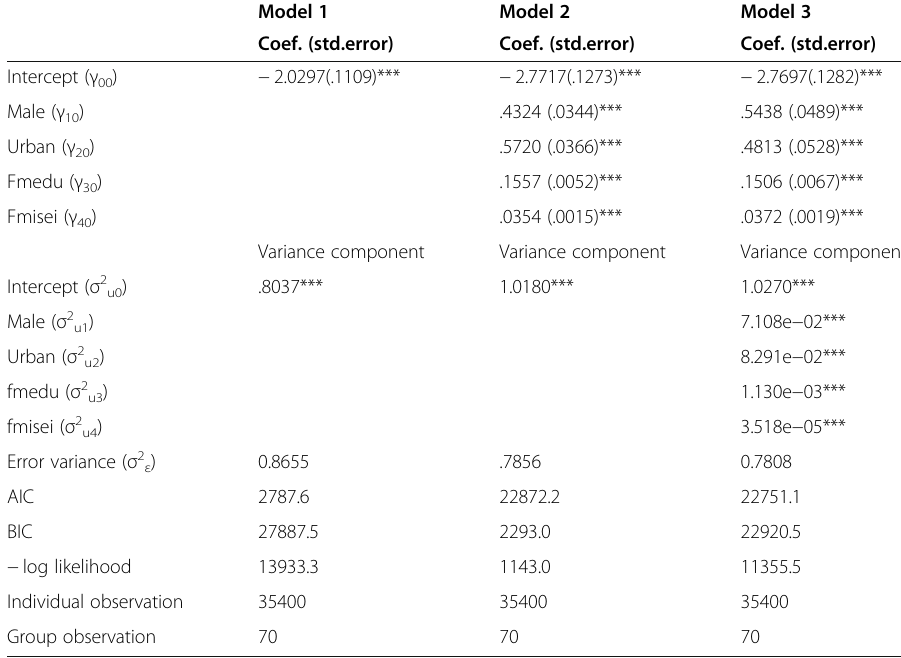
Table 3 Multilevel logistic regression on higher education Model